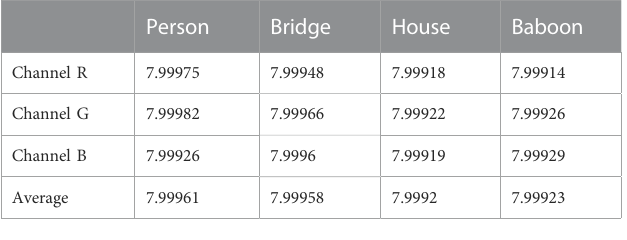
TABLE 2 Information entropy of three channels. Person Bridge House